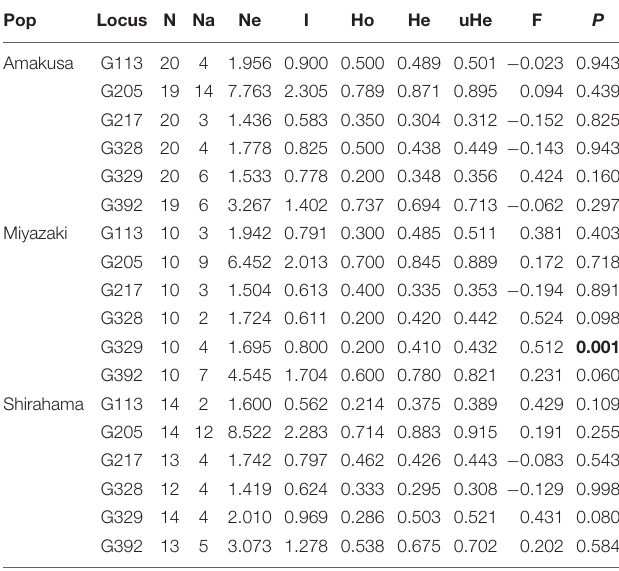
TABLE 3 | Summary for the basic population genetic parameters using microsatellite loci. Pop Locus N Na Ne I Ho He